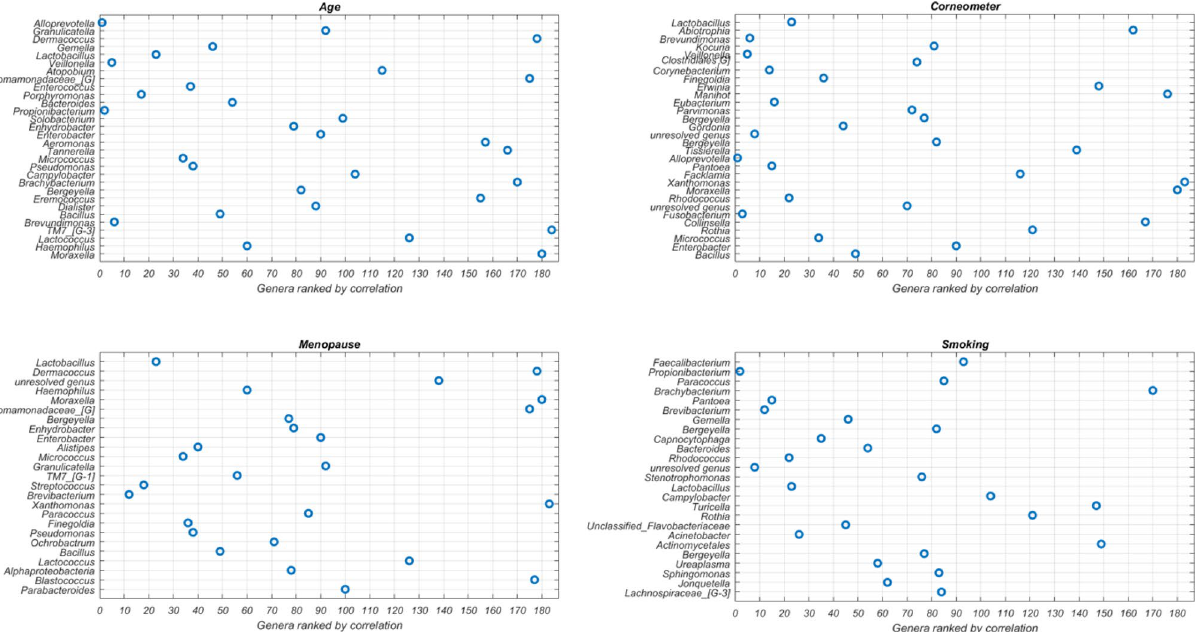
Figure 3. Feature ranking from statistical test. Visualization of the most impactful genera per phenotype. On the y-axis the ranked impactful genera as generated by SHAP (the most impactful genus at the top) are shown. On the y-axis the rankings in independent statistical tests (the most significant (smallest p-value) genus is on the left) are shown. Note that the total number of genera is 186. This image has been generated using Matlab R2017a at https ://www.mathw orks.com/produ cts/matla